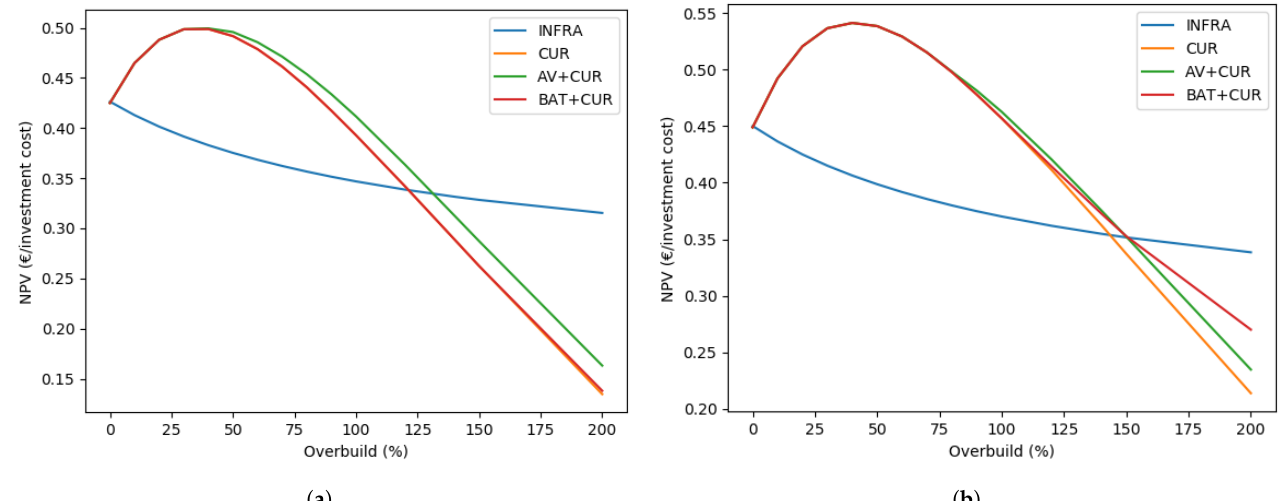
Figure 6. NPV using ( a ) SDE+ and ( b ) 2030 prices for the different